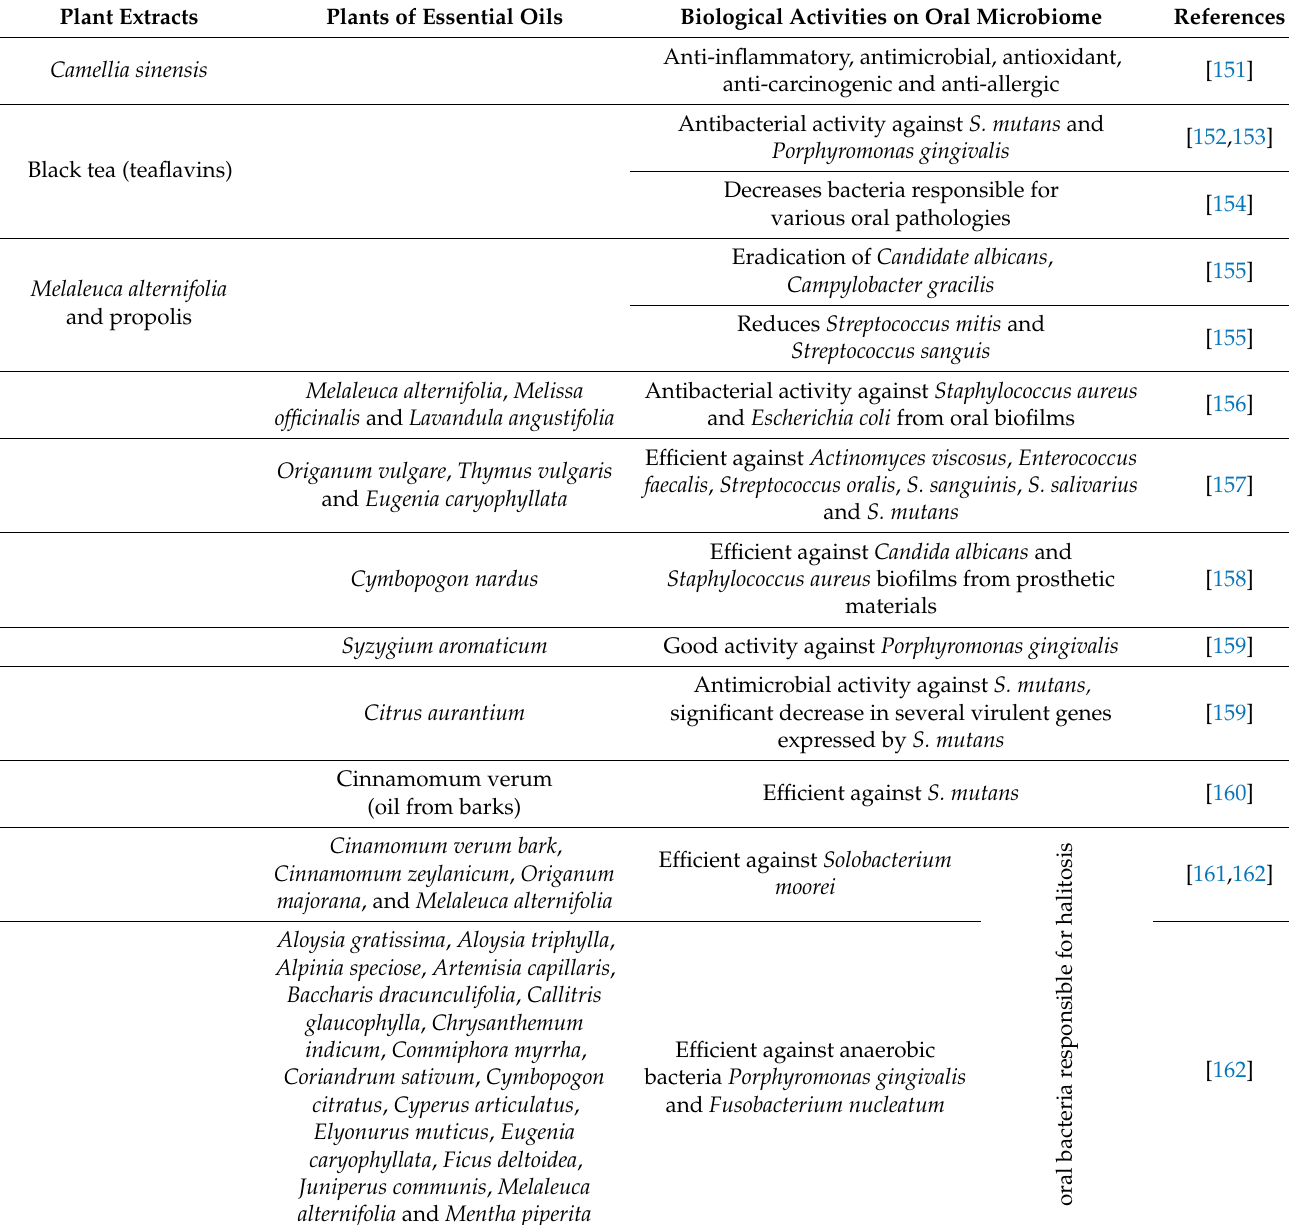
Table 2. Plant-derived ingredients that influence the oral